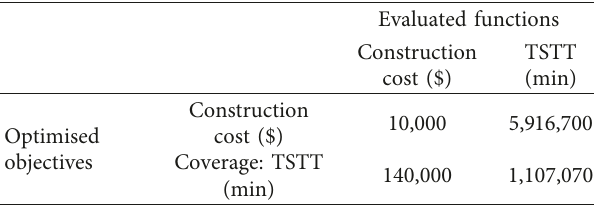
Table 7: Flow on links of network when minimising TSTT of